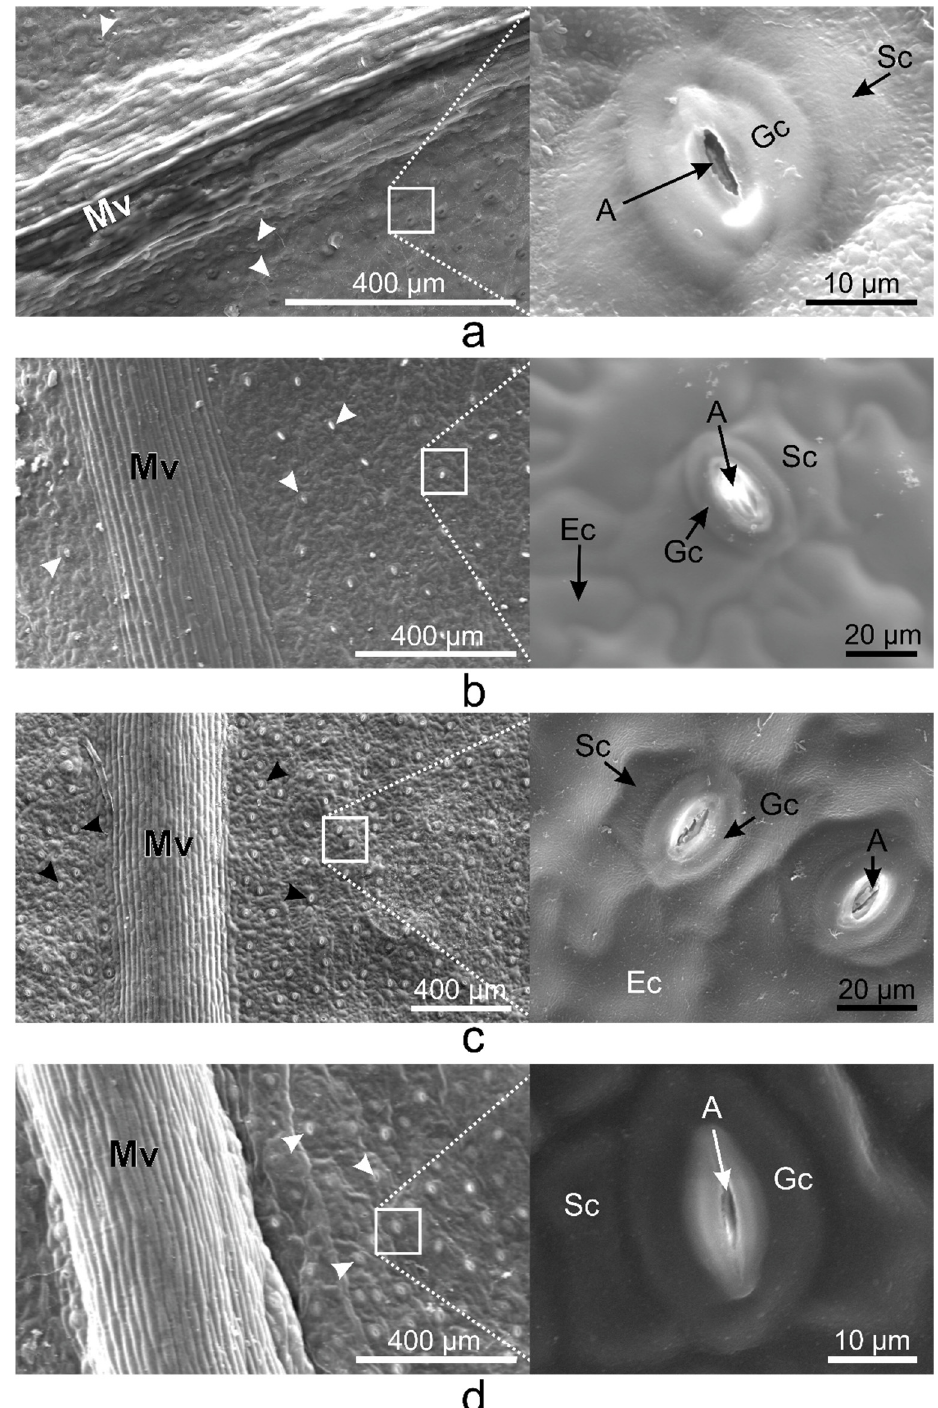
Figure 2. SEM micrographs showing the abaxial (lower) epidermis of the Vinca leaves with an overview along the midvein and detailed view of the stomata. ( a ) V. minor , ( b ) V. major , ( c ) V. major var. variegata , ( d ) V. herbacea ; A—aperture, Ec—epidermal cell, Gc—guard cell, Mv—midvein, Sc—subsidiary cell, arrowheads—stomata.